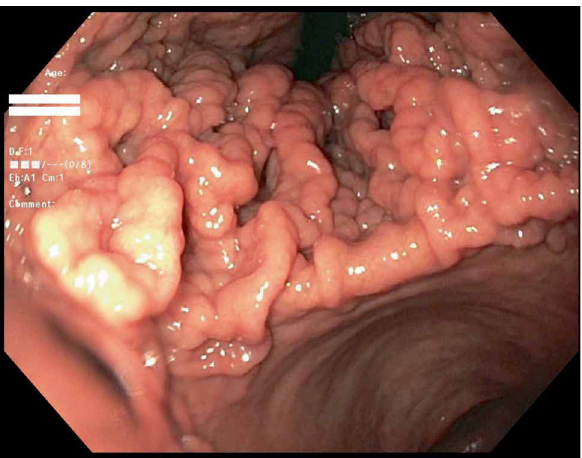
Figure 1: Esophagogastroduodenoscopy showing diffusely thick gastric folds were found in the gastric fundus and in the gastric body with characteristic sparing of Figure 1. The biopsied enlarged gastric folds revealed gastric fundic mucosa with foveolar hyperplasia, dilated fundic glands and chronic gastritis which is shown in Figure 2. Another gas- foveolar hyperplasia and mild chronic inflammation.